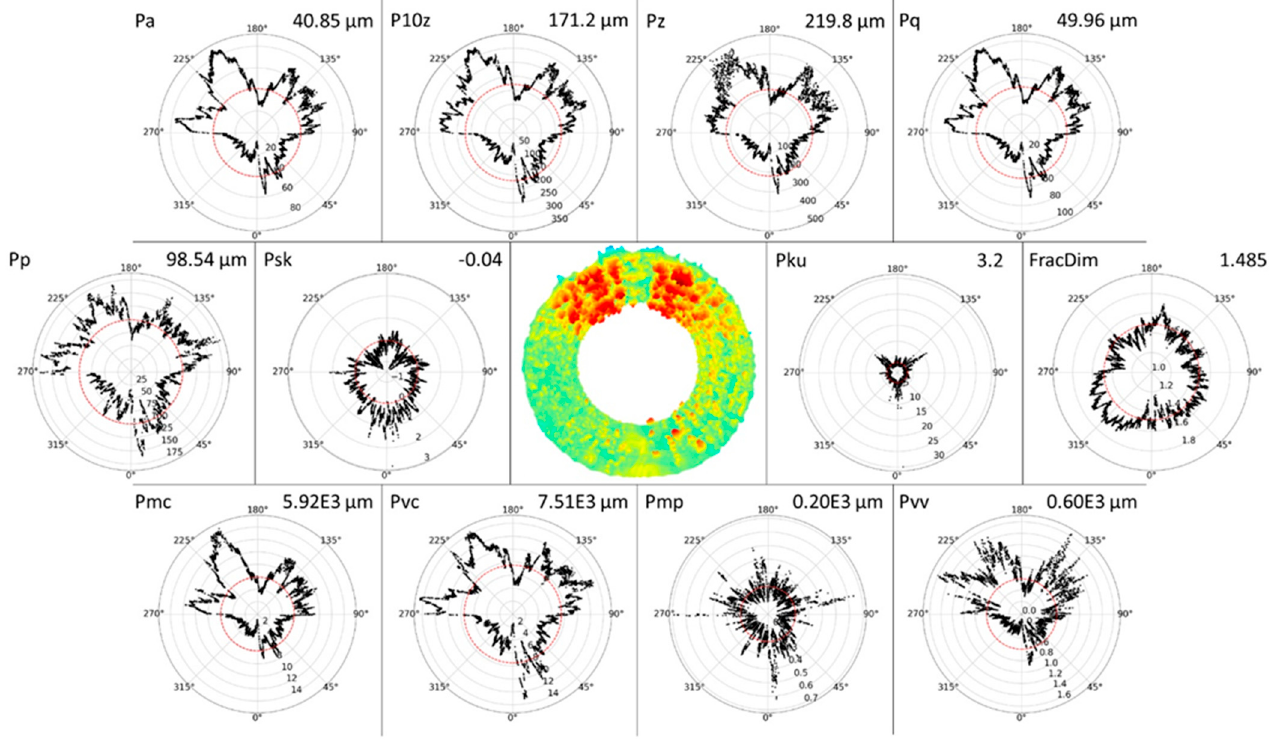
Figure 14. Polar plots showing the calculated profile parameters together with surface deviation maps showing the observed roughness and dross formation for channel 6 mm A. The scale is radial and the unit for each profile parameter is given together with the overall average value in the top right corner.